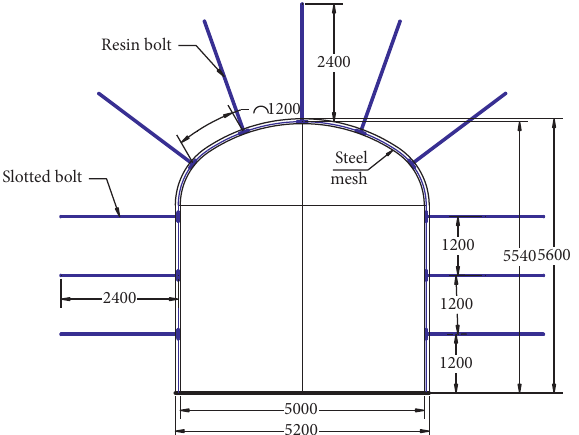
Figure 2: Original support scheme of deep